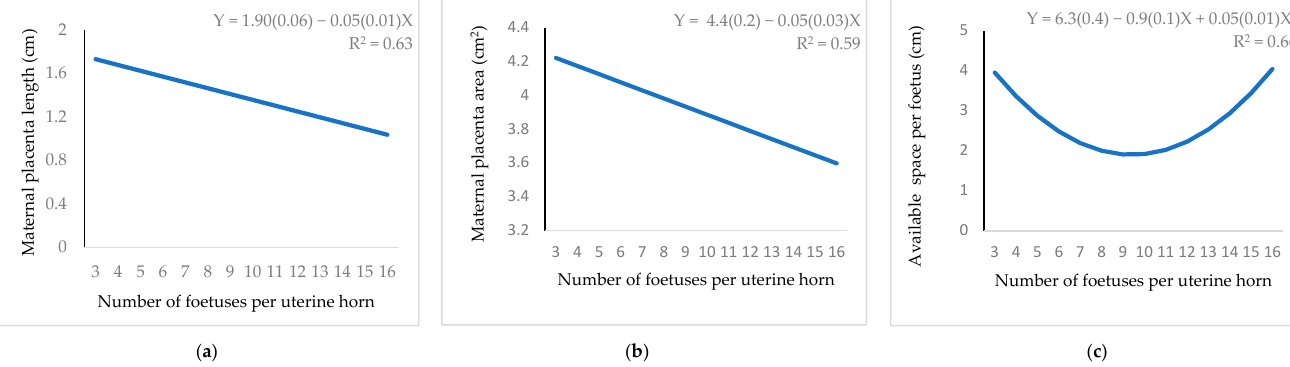
Figure 7. Regression equation (standard error between brackets) at 12 d of gestation for the relationship between number of foetuses per uterine horn and: ( a ) maternal placenta length; ( b ) maternal placenta area; ( c ) available space per foetus.